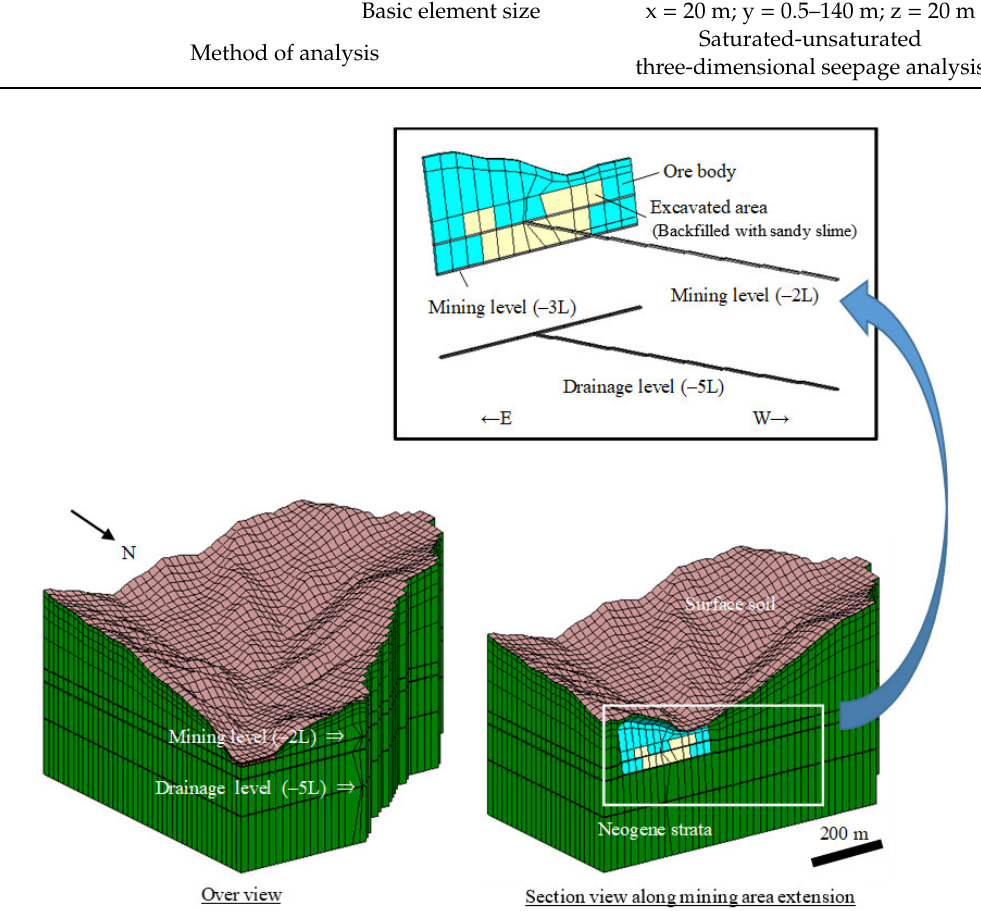
Figure 3. Simulation model of three-dimensional groundwater flow.